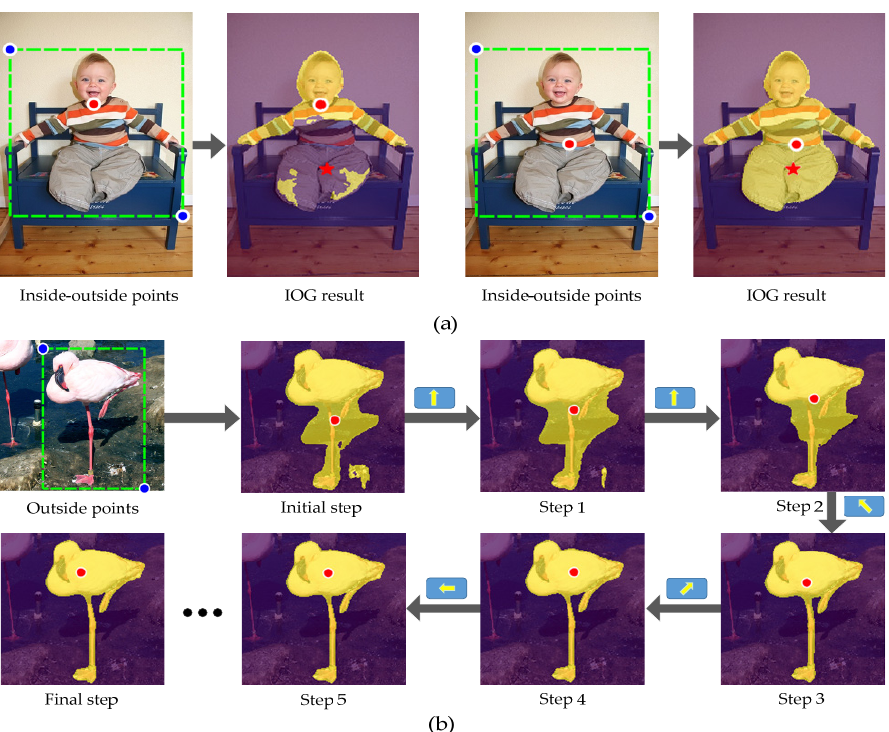
Figure 1. The blue and red dots represent the outside and inside points, respectively. ( a ) IOG [16] segmentation example with different inside points. “ ★ ” denotes the simulated inside point located at the object center. ( b ) Automatic inside point localization process through the IPL-Net. At each step, the IPL-Net moves the inside point to a new